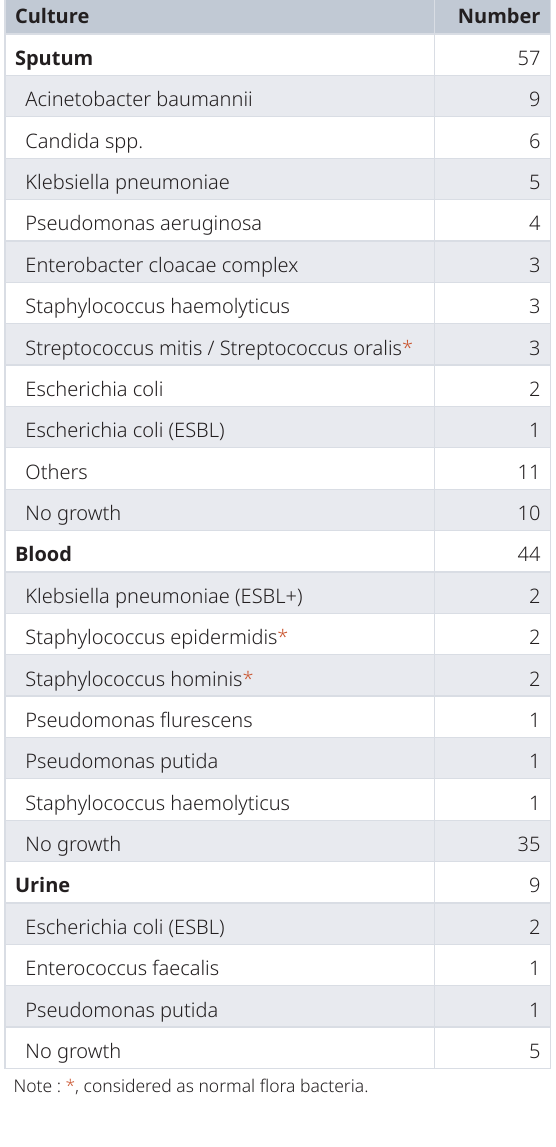
Table 3. Result of microbiological culture.